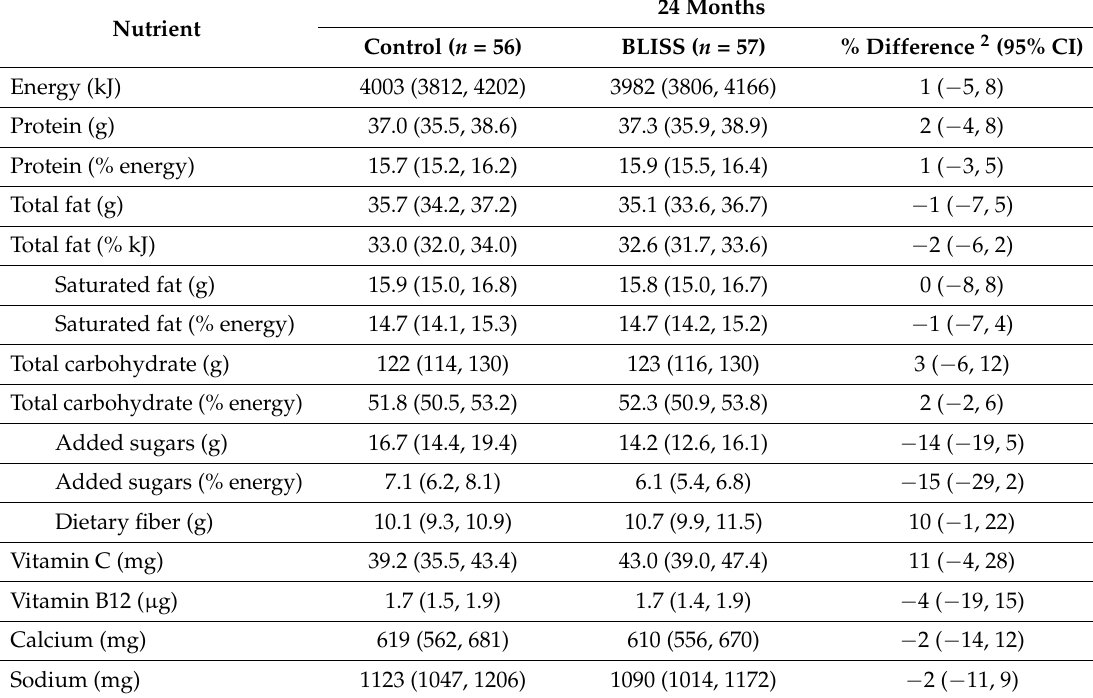
Table 5. Nutrient intake from complementary foods and milk (infant formula and/or breast milk) at 24 months of age.